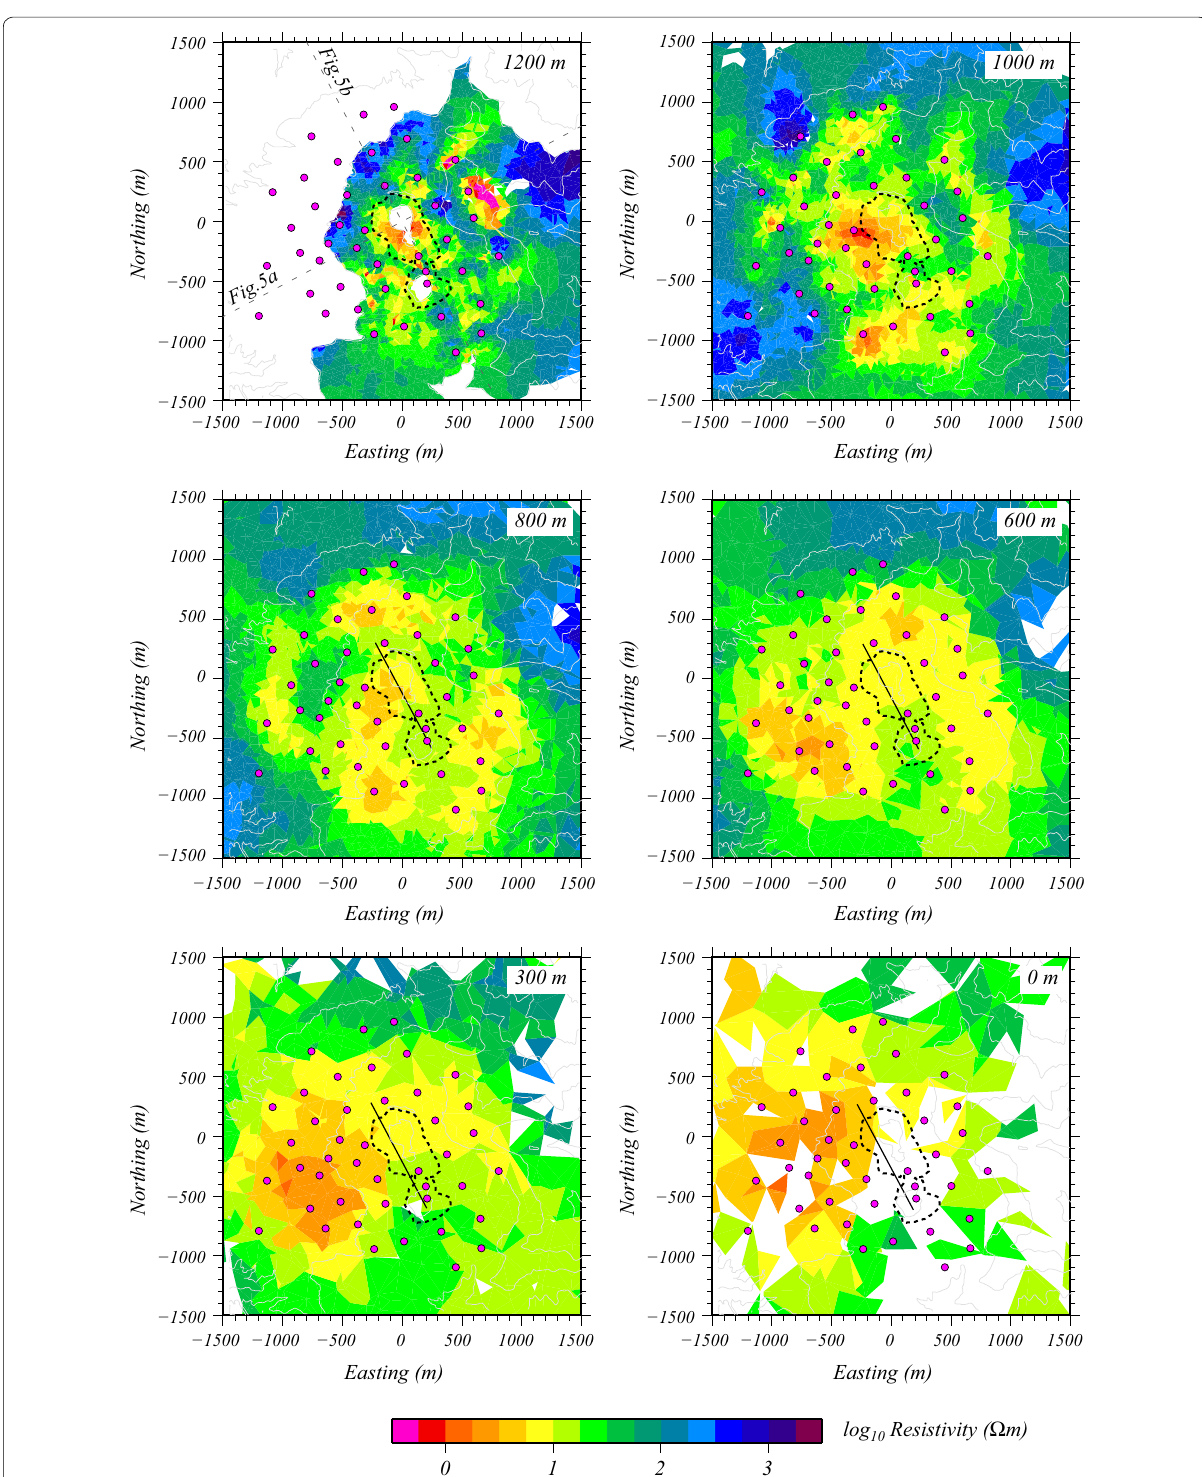
Fig. 4 Horizontal sections of the final 3-D resistivity model for six different elevations. Horizontal sections of resistivity for elevations of 1200, 1000, 800, 600, 300, and 0 m. The dashed line in each diagram indicates the projection of the outline of the Nakadake crater system. The solid line shown in the diagrams for 800, 600, 300, and 0 m represents the intersection of each section with the crack-like conduit reported by Yamamoto et al. (1999). The red circles indicate AMT